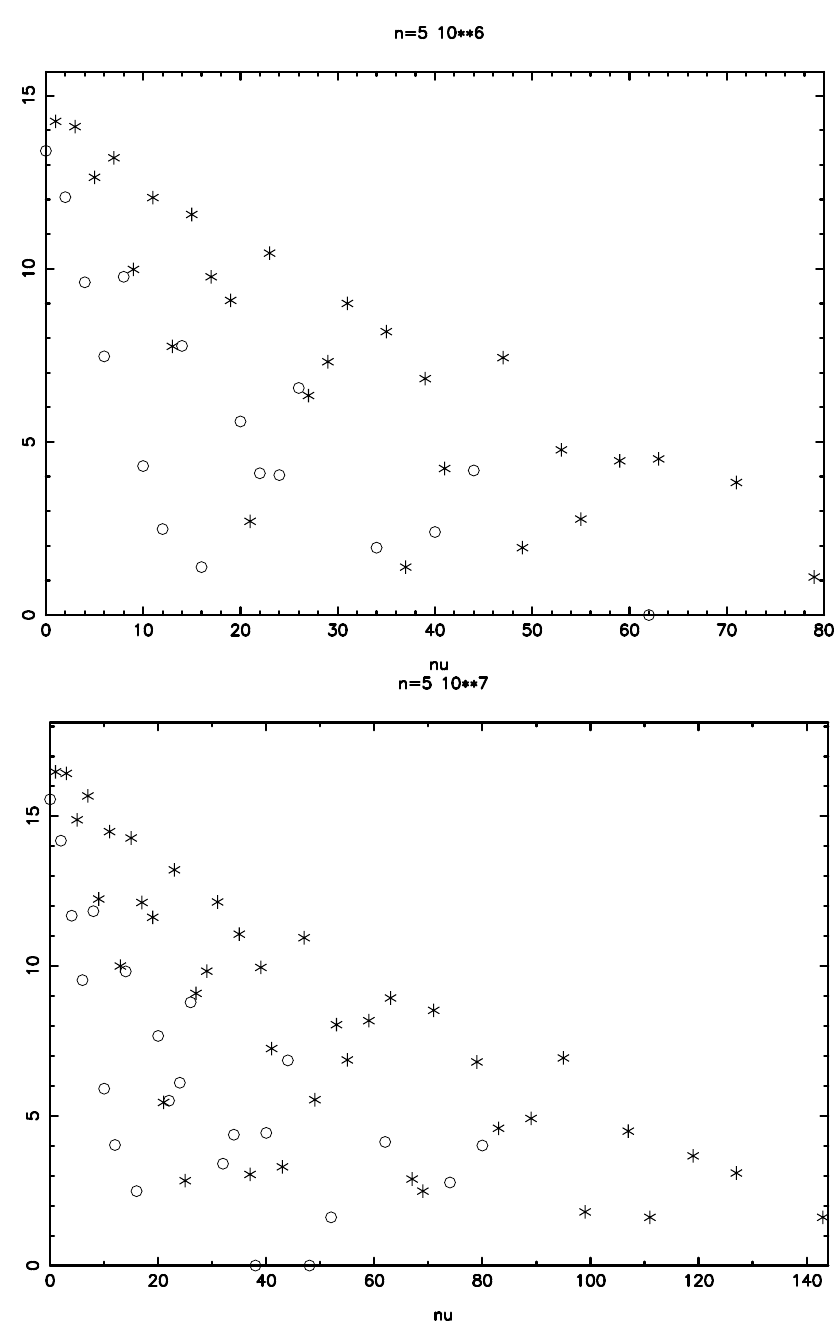
( ν )) vs. ν for n = 5 10 6 , n = 5 10 7 . Circle: ravens , n